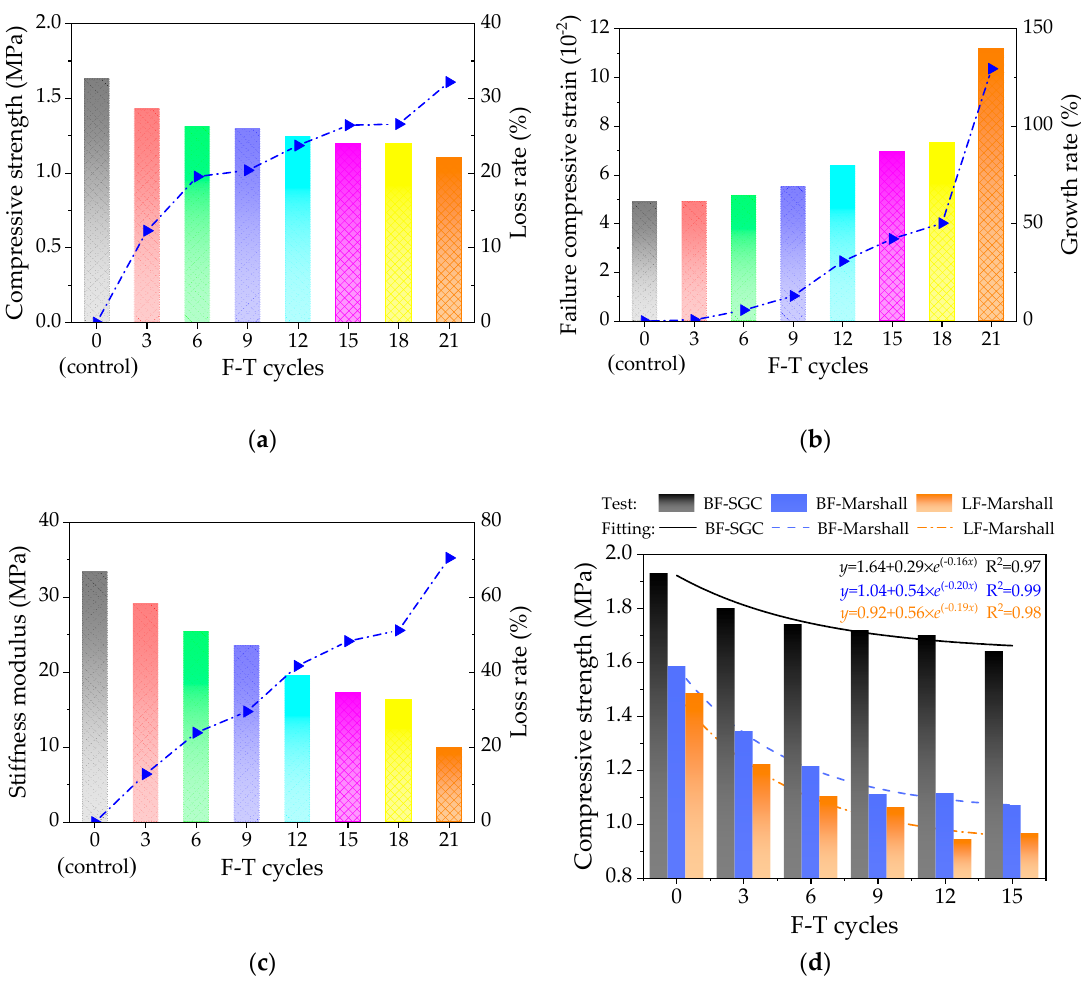
Figure 6. The high-temperature uniaxial compression results: ( a ) compression strength, ( b ) failure strain, ( c ) compression failure stiffness modulus, and ( d ) comparative results.